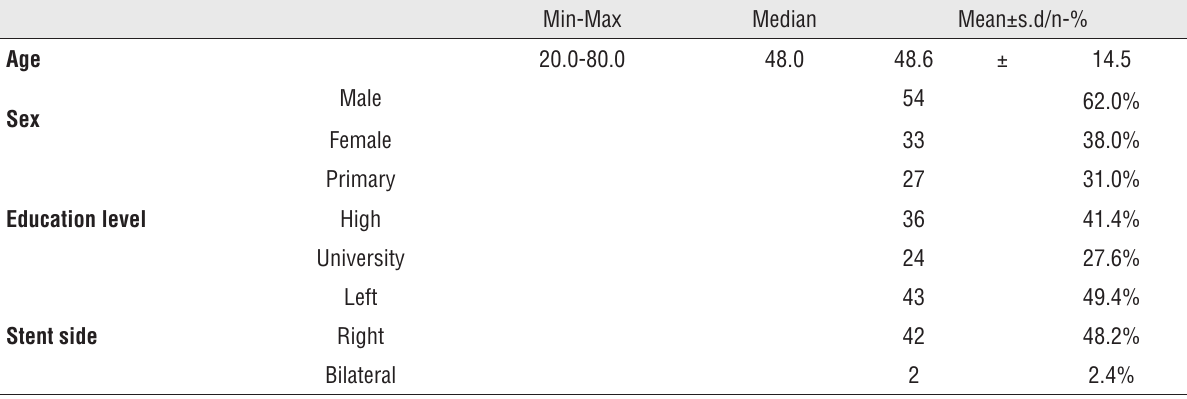
Table 1 - Patients’